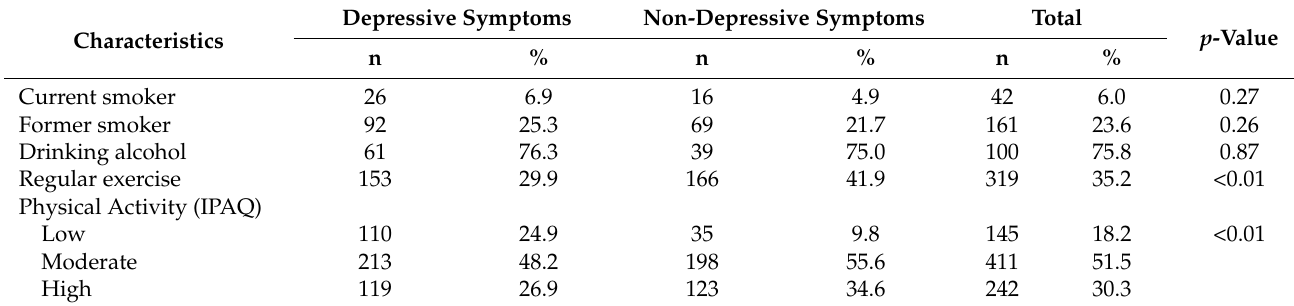
Table 3. Health-related behavior among older people.